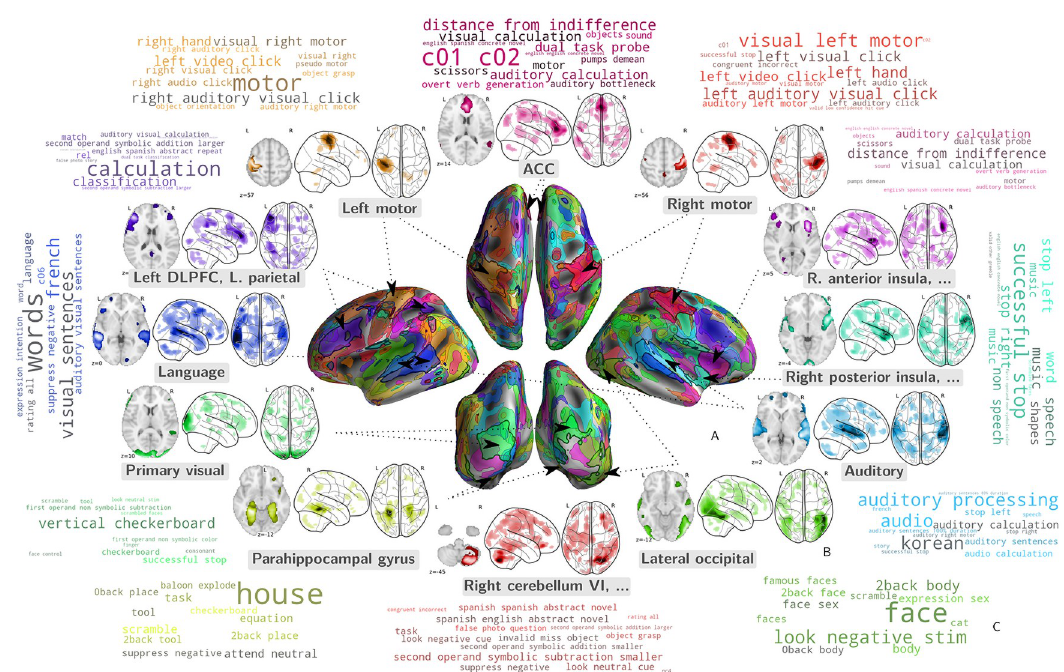
Fig 4. Visualization of some of task-optimized networks. Our approach learns networks that are important for decoding across studies. These networks are individually focal and collectively well spread across the cortex. They are readily associated with the cognitive tasks that they contribute to predict. We display a selection of these networks on the cortical surface (A) and in 2D transparency (B) , named with the salient anatomical brain region they recruit, along with a word-cloud (C) representation of the stimuli whose likelihood increases with the network activation. The words in this word cloud are the terms used in the contrast names by the investigators; they are best interpreted in the context of the corresponding studies.